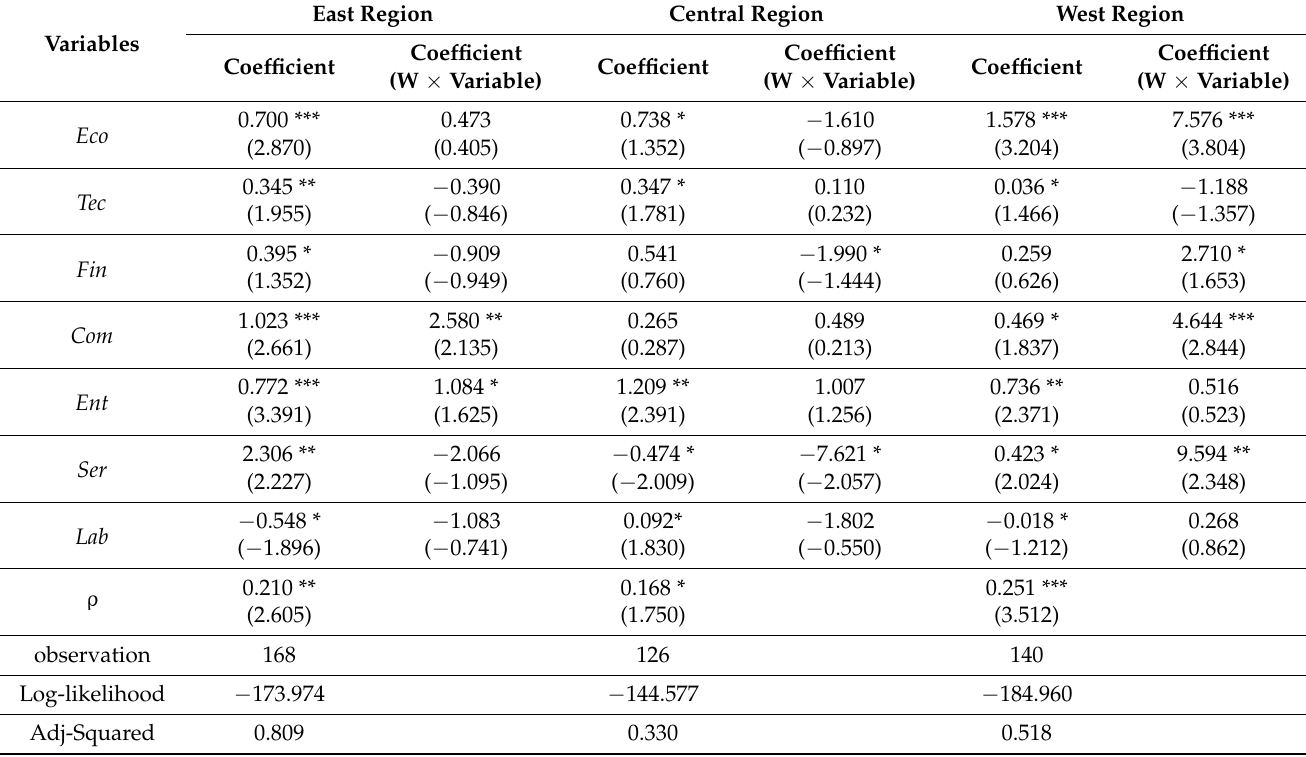
Table 7. Regression results of eastern, central, and western region